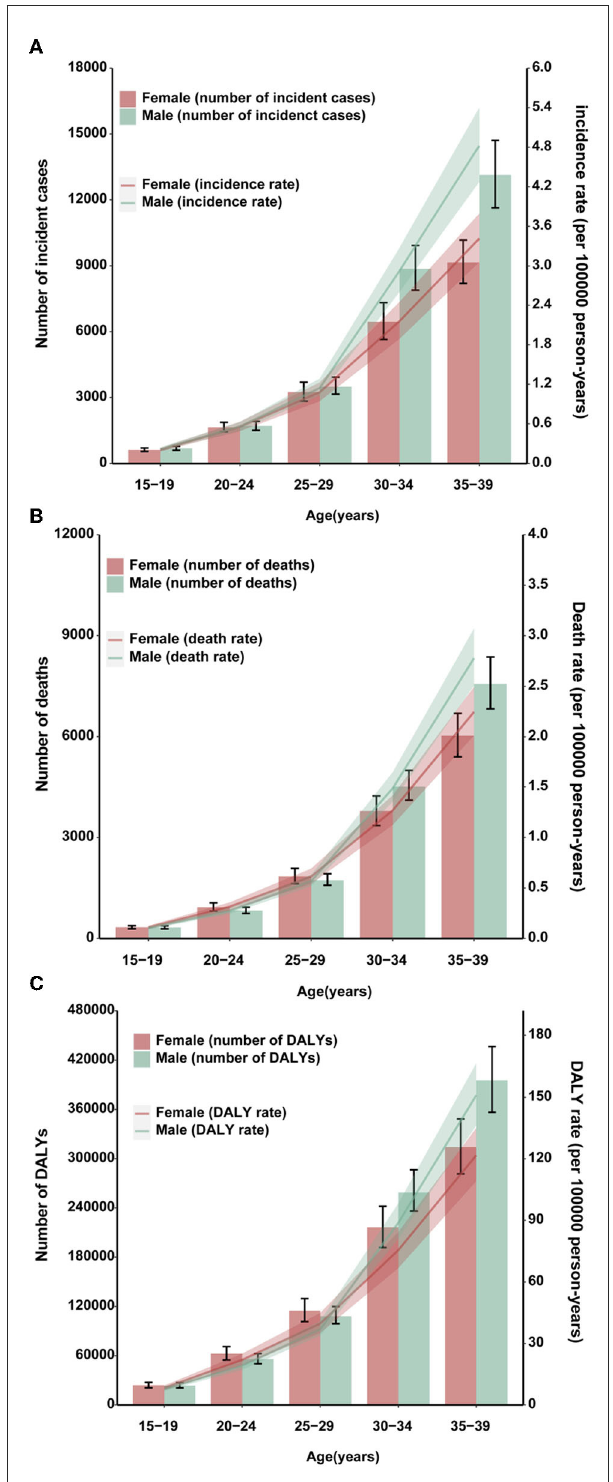
FIGURE1 Burden of AYA stomach cancer in 2019. Global age-specific counts and rates of incident cases (A) , deaths (B) , and DALYs (C) of AYA stomach cancers per 100,000 population by sex,